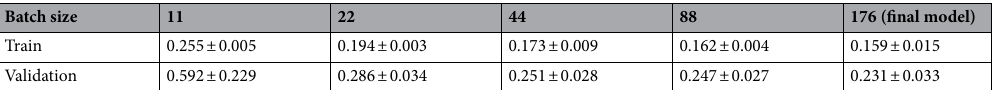
Table 2. Dice losses for our model trained using different batch sizes with multi-sequence images. Data are presented as the mean and standard deviation. Train : train loss, Validation : validation loss.